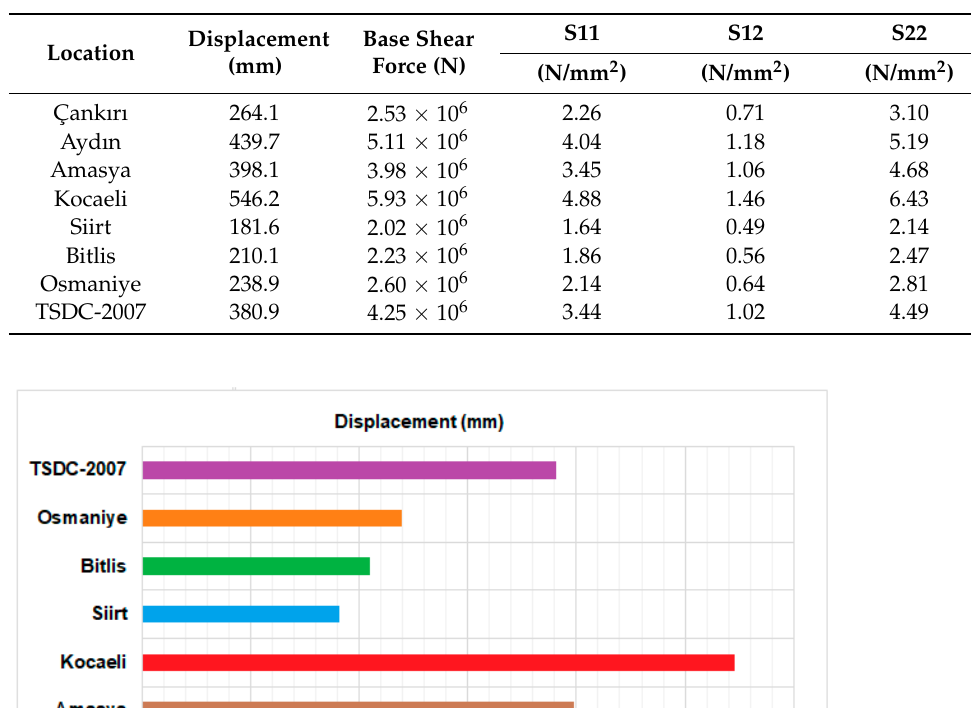
Table 14. Design earthquake drift controls.